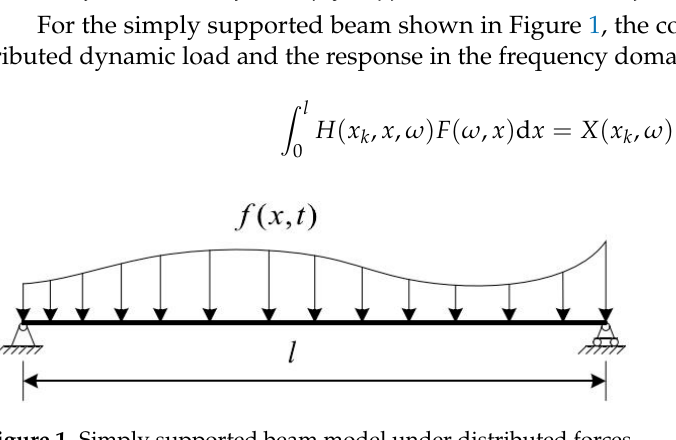
Figure 1. Simply supported beam model under distributed forces. Here, H ( x k , x , ω ) denotes the frequency response function (FRF), x k is the response position, and X ( x k , ω ) is the frequency response. F ( ω , x ) , which is rewritten as Equation (2) into Equation (1), Equation (1) is rewritten as Equation